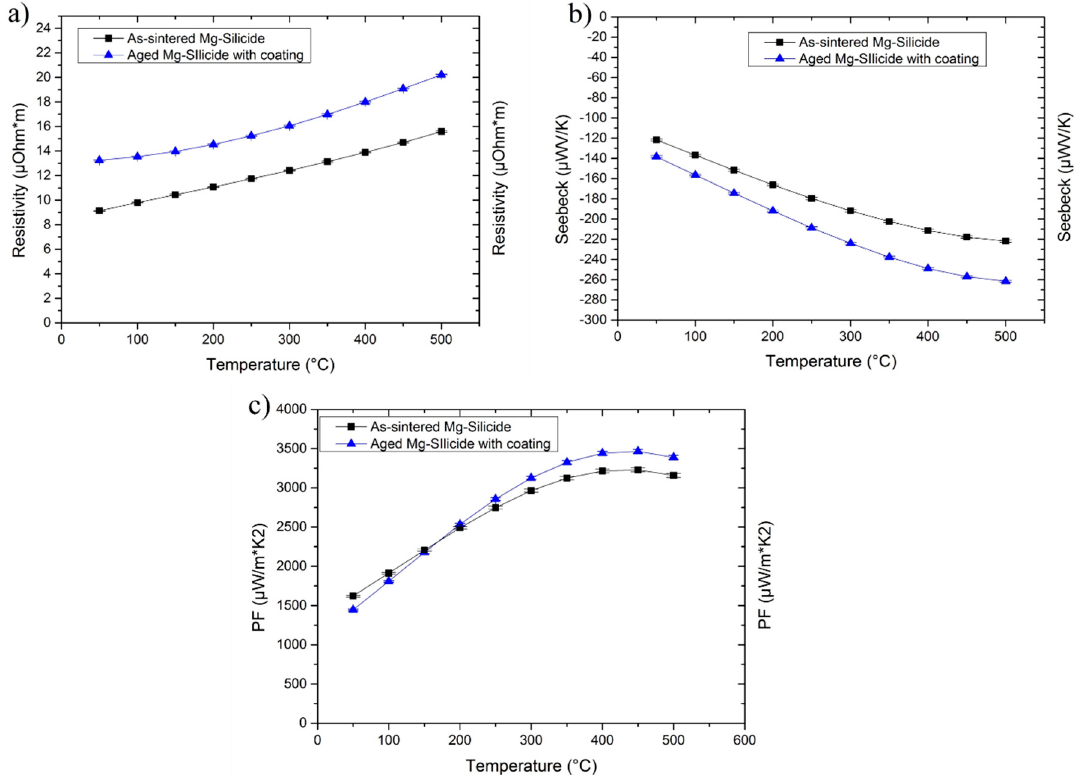
Figure 5. Temperature dependence of the: ( a ) Electrical resistivity; ( b ) Seebeck coefficient; and ( c ) Power Factor for Mg-silicide as sintered and coated after ageing at 500 °C for 120 h, uncoated could not be measured. (For all electrical measurements, the outer layers were removed coated sample to reveal pristine silicide onto which electrical contacts have been made).